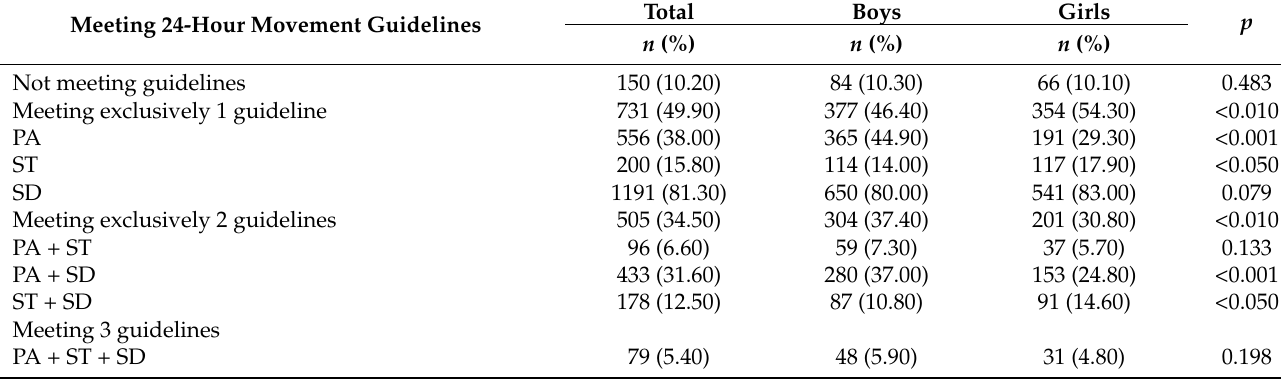
Table 2. Meeting of 24-Hour Movement Guidelines among adolescents’ boys and